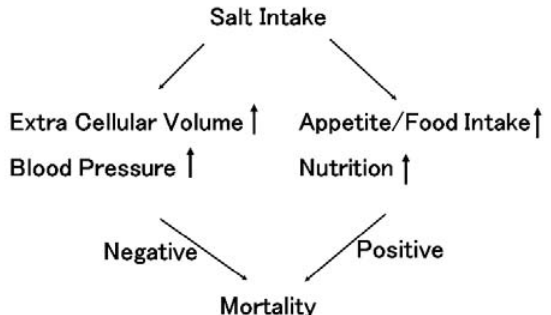
Figure 1. The influence of salt intake on mortality. Salt intake increases extracellular volume, resulting in increased blood pressure in both the general population and chronic kidney disease (CKD) patients, including dialysis patients. Hypertension is considered to worsen prognosis. This salt sensation higher in CKD patients than in the general population. In contrast, salt intake increase appetite. Under the same salt taste, salt intake is basically proportional to the amount of food intake. Good nutritional conditions improve prognosis. Therefore, salt intake has dual effects on prognosis, both negative and positive effects.